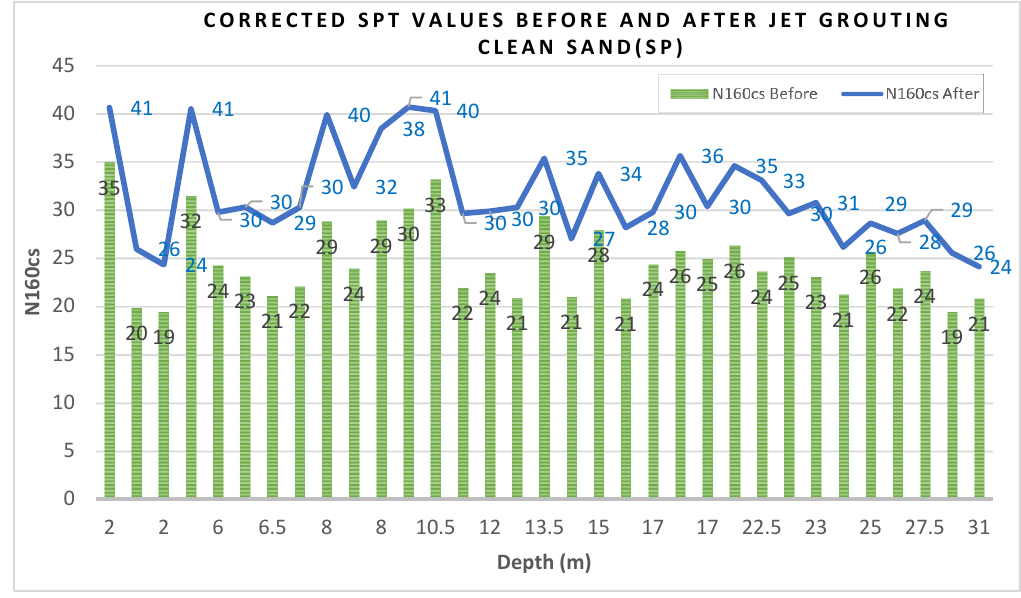
Figure 6. Corrected SPT values before and after jet grouting using micropiles in the soil profile containing only poorly graded sand.